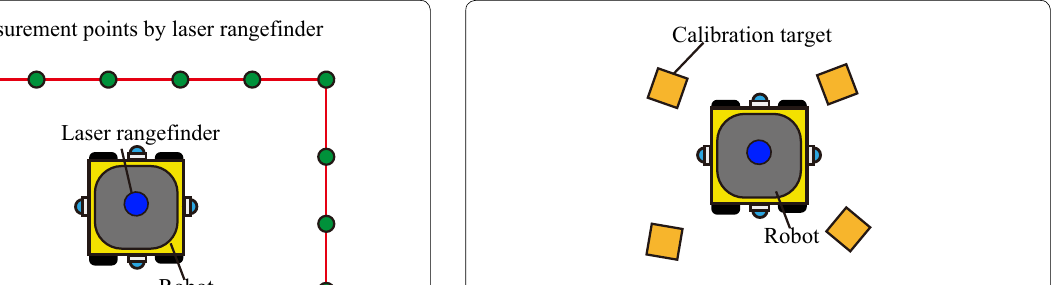
Fig. 5 Calibration targets placed on the floor (Top view). If four cameras are mounted on the robot, four square boards should be placed as the calibration targets on the floor so that at least two cameras can capture